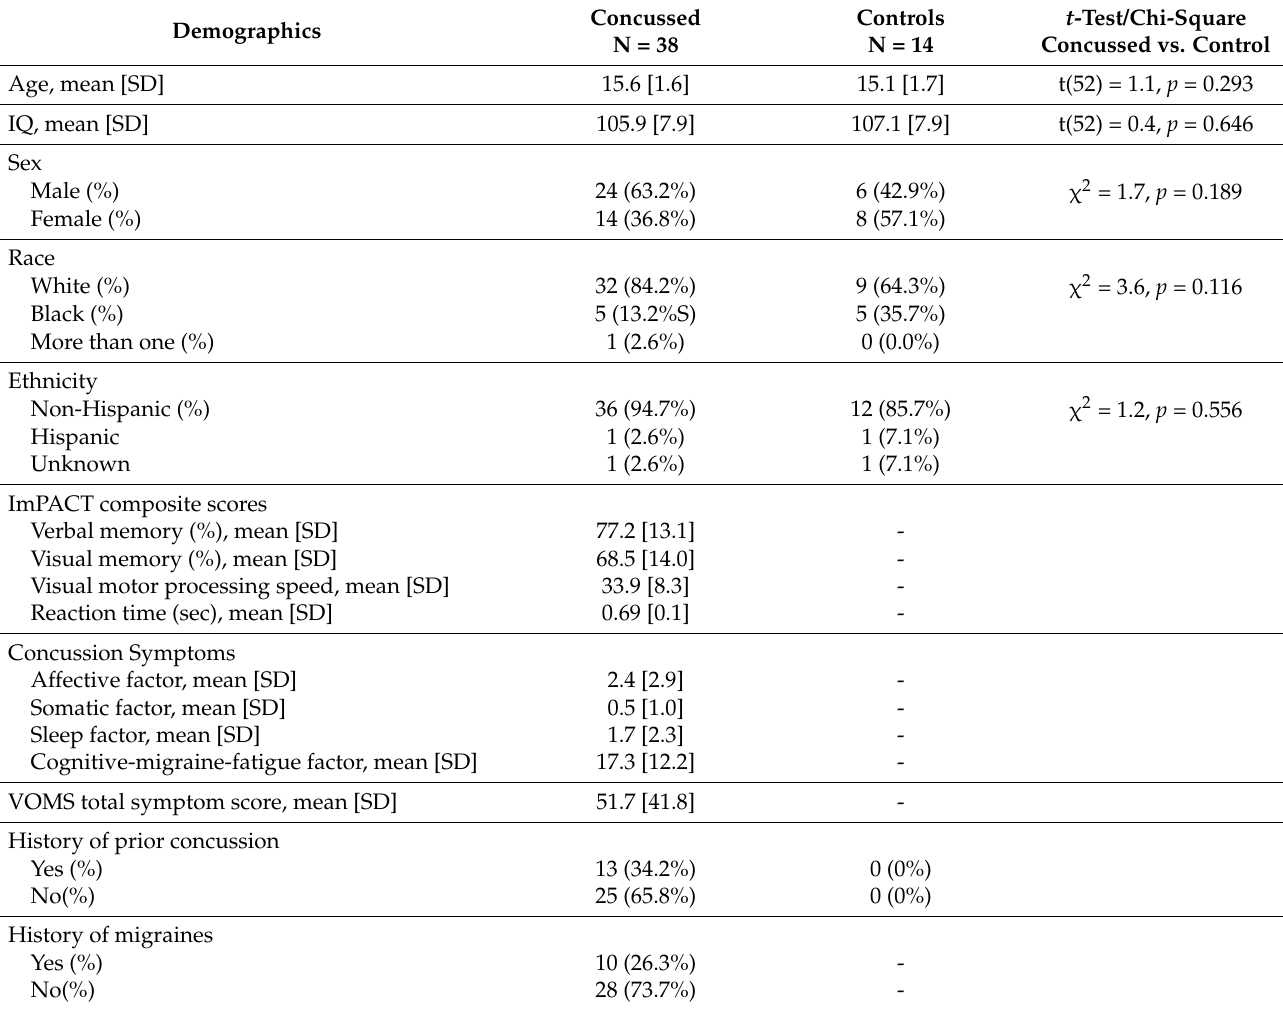
Table 1. Subject demographics and clinical